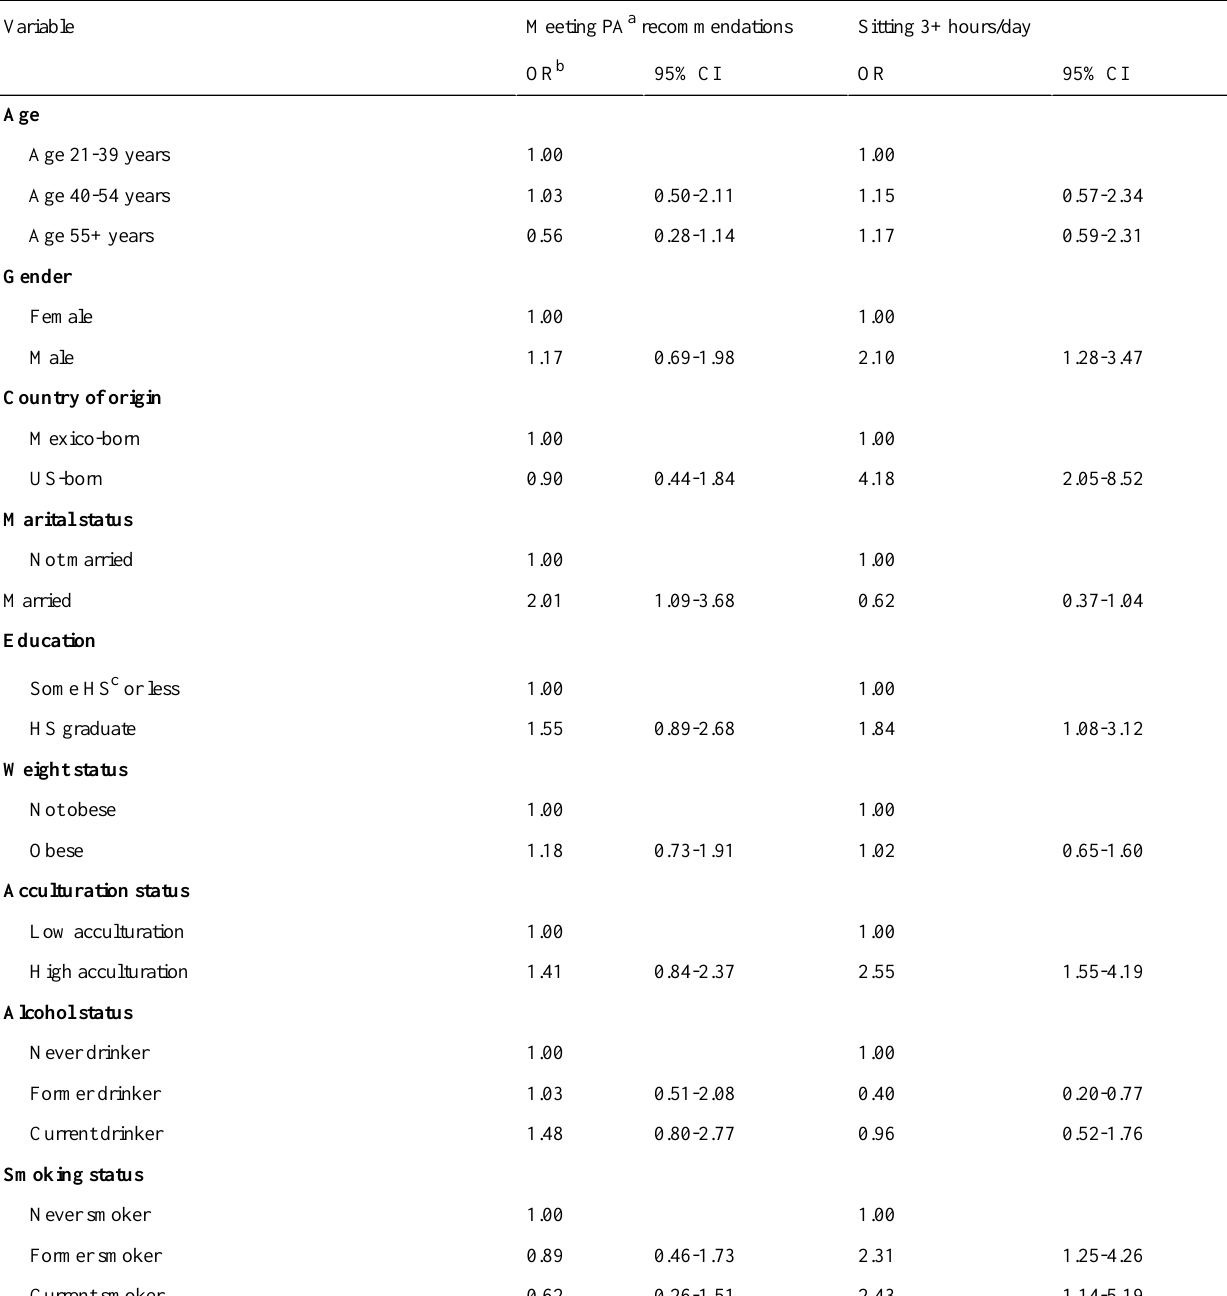
Table 3. Unadjusted odds ratios (95% CI) for mobile phone nonusers for meeting physical activity recommendations and sitting 3 or more hours per day